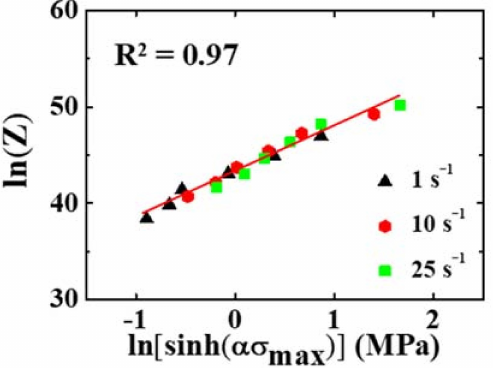
Figure 6. Hyperbolic sine function of flow stresses obtained from inverse analysis according to the Zener–Holloman